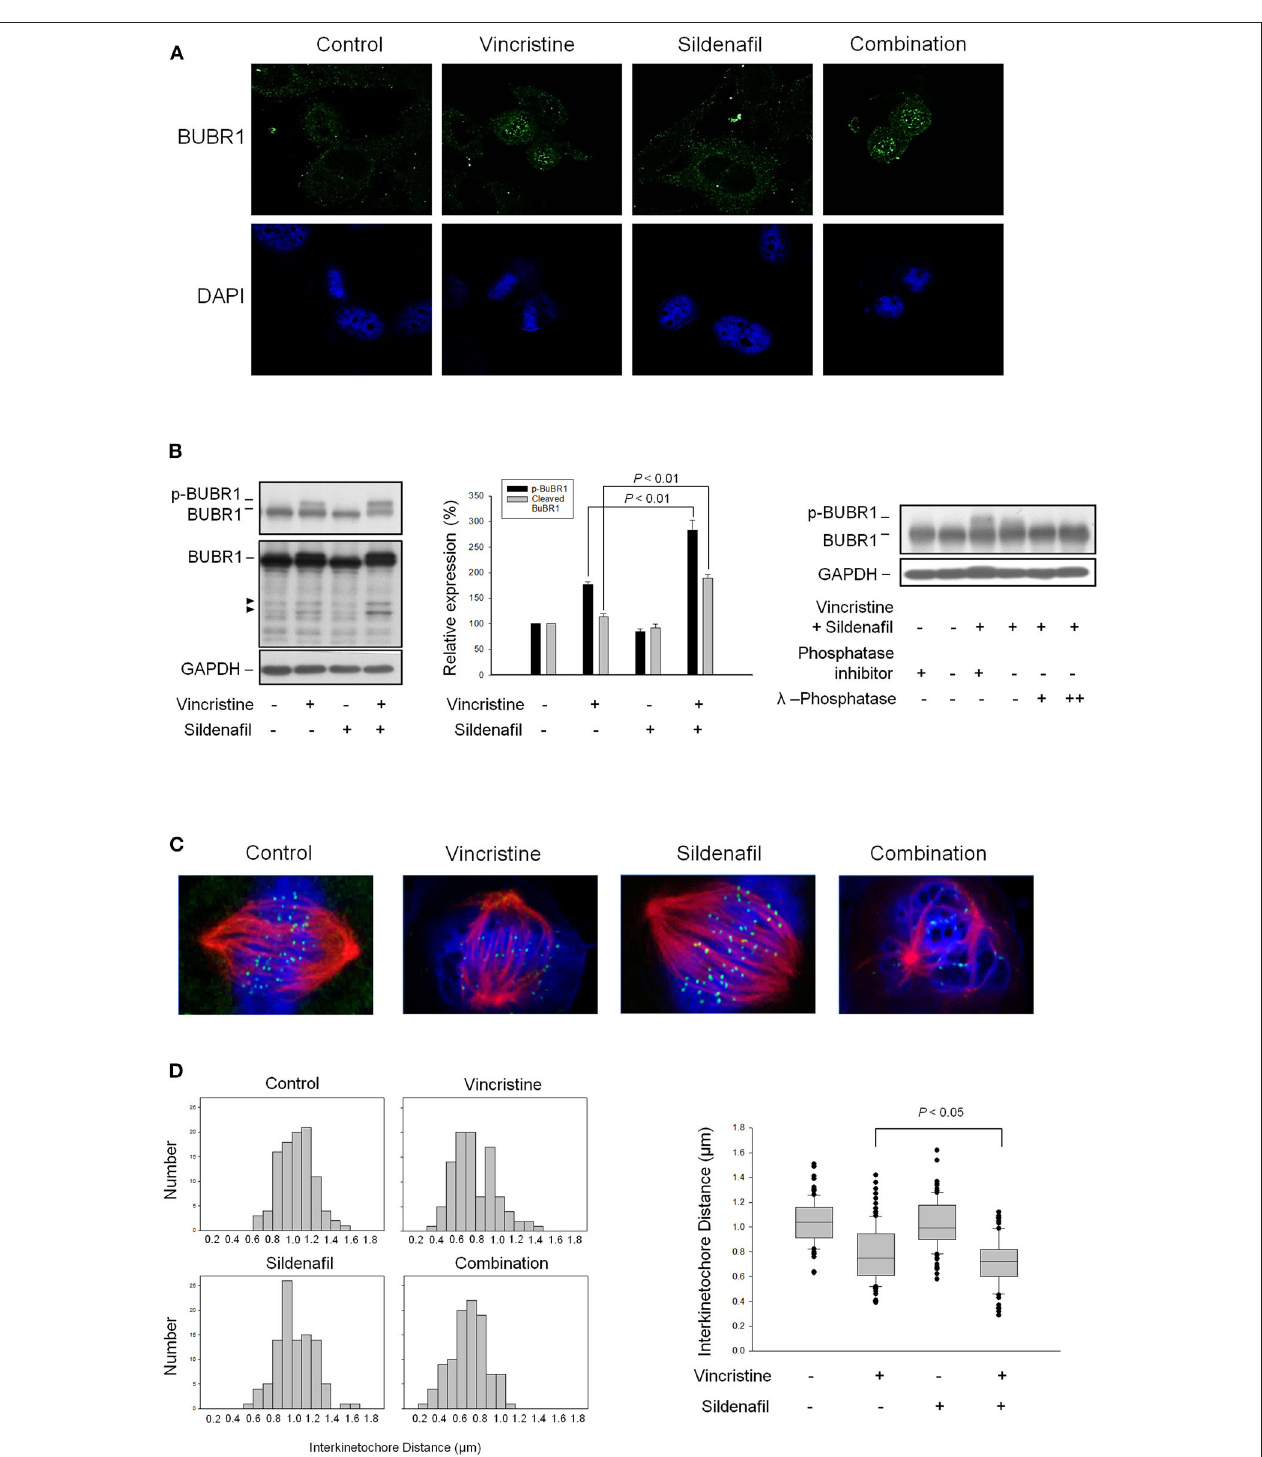
FIGURE 5 | Effect of sildenafil and vincristine on BUBR1 expression and the distance between kinetochore pairs in PC-3 cells. The cells were incubated in the absence or presence of sildenafil (10 µ M) and/or vincristine (10nM) for 24h. The confocal immunofluorescence examination was performed to detect BUBR1 (green) and chromosome (blue) using BUBR1 antibody and DAPI, respectively (A) , or the cells were harvested and lysed for the detection of protein expression by Western blot analysis (B) . Data are expressed as mean ± SEM of three independent determinations. Furthermore, BUBR1 phosphorylation was validated by the absence of phosphatase inhibitors or the presence of phosphatase. Both conditions significantly decreased the phosphorylation levels. (C) Confocal immunofluorescence microscopic examination was performed to detect kinetochore (green), microtubule (red), and chromosome (blue) using CENP-A antibody, β -tubulin antibody, and DAPI, respectively. (D) The distances between paired kinetochores ( n = 100) were blindly measured at individual z planes, scored from 5 to 8 cells.